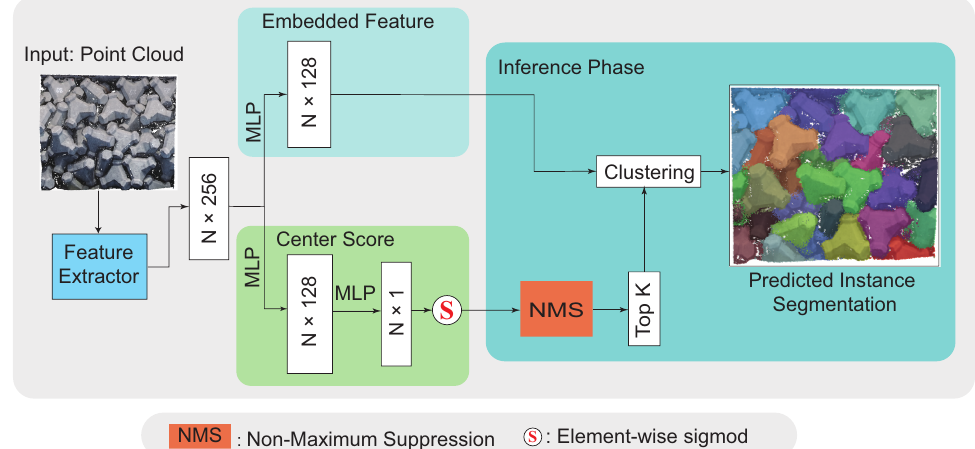
Figure 3. Network architecture of FPCC [14]. After the Center Score branch predicts the probability that each point is likely to be the centroid of the object, non-maximum suppression is used to select the most likely centroids as reference points for clustering. The reference and remaining points are clustered according to the L2 distance in feature space. Our improvement aimed for FPCCv2 is the feature extractor (Section 4.2), where the features of point clouds can be exploited more effectively than the original FPCC.